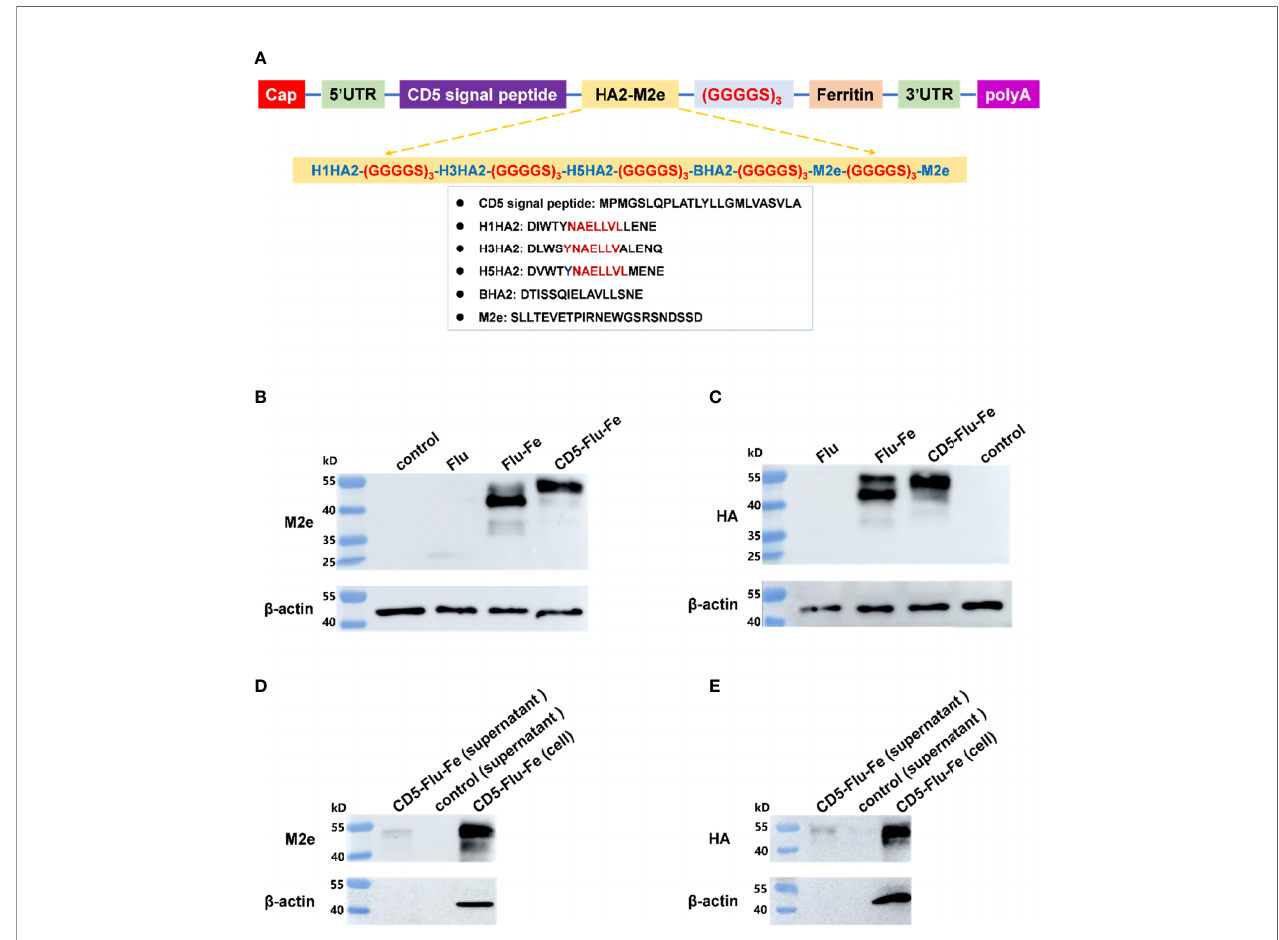
FIGURE 3 | Expression veri fi cation of vaccine antigen genes. (A) The schematic illustration of antigen gene CD5-Flu-Fe. Cap, Cap structure of mRNA; UTR, non- translational region; HA2, the conserved antigen epitope in the stem region in in fl uenza virus hemagglutinin gene; M2e, the conserved antigenic epitopes in in fl uenza virus M gene; polyA, polyadenosyl nucleotide; GGGGS, a fl exible linker. (B) Veri fi cation of intracellular M2e protein expression. (C) Veri fi cation of intracellular HA protein expression. (D) Detection of M2e antigen in the supernatant of CD5-Flu-Fe transfected cells. (E) Detection of HA antigen in the supernatant of CD5-Flu-Fe transfected